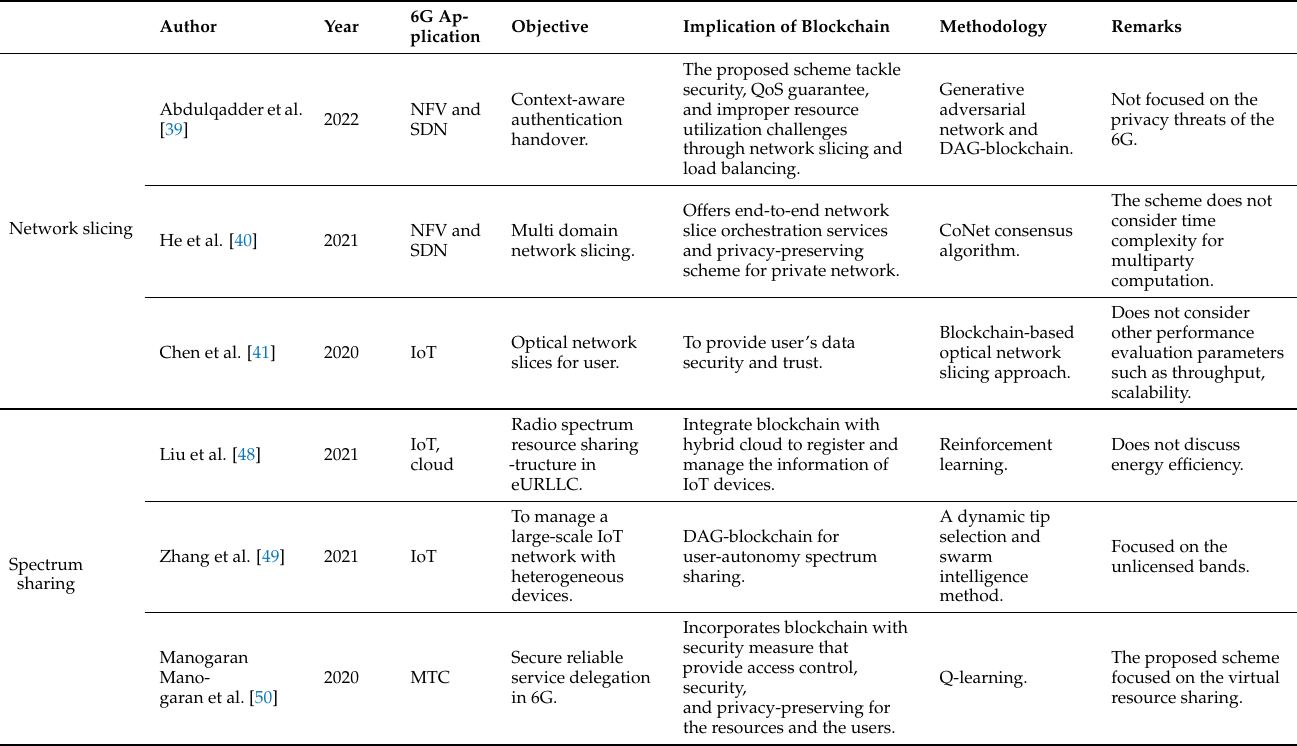
Table 2. A comparative analysis of blockchain-based 6G